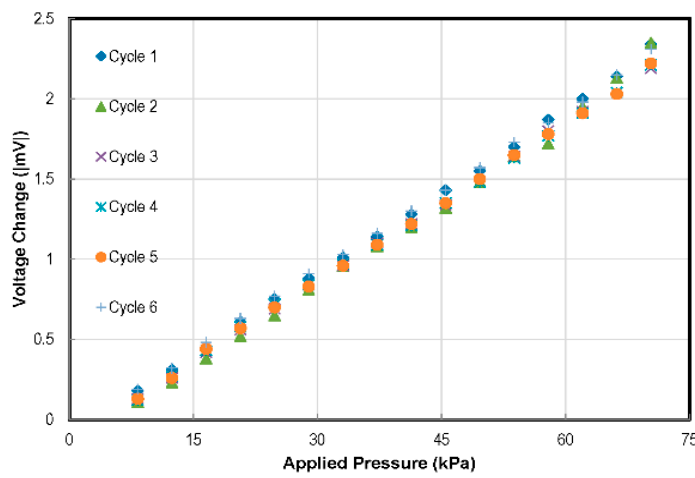
Figure 13. Repeatability test results of the pressure sensor in the SOI CMOS MEMS chip.